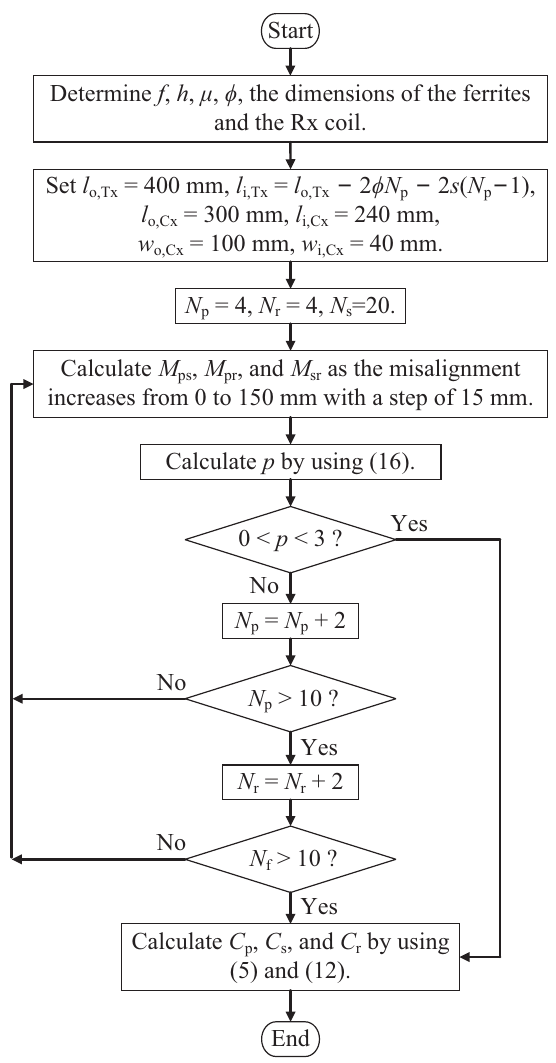
Figure 4. Design flowchart of the coil structure and the compensation